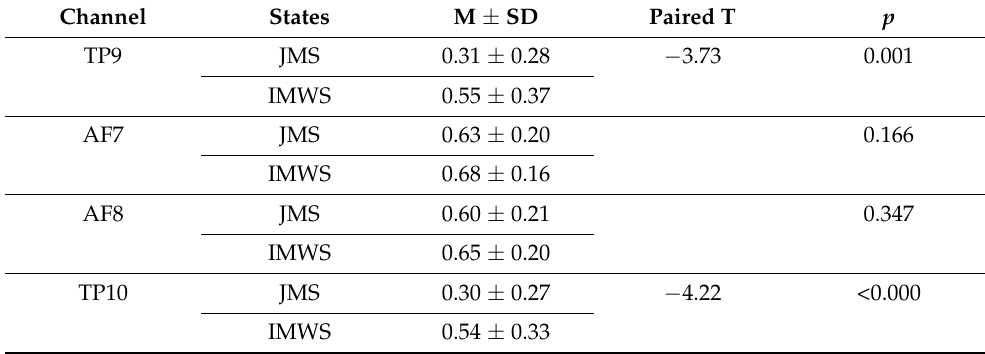
Table 1. Differences in theta/alpha ratio for the two states by channel. Channel States M ± SD Paired T